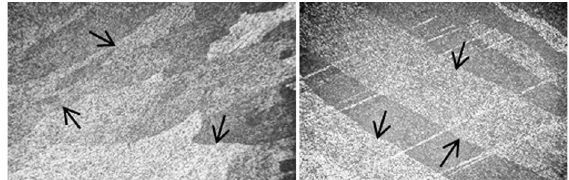
Fig. 5. Cross-cut of forging produced by Regime A (black arrows show the boundaries of coarse recrystallized grains)